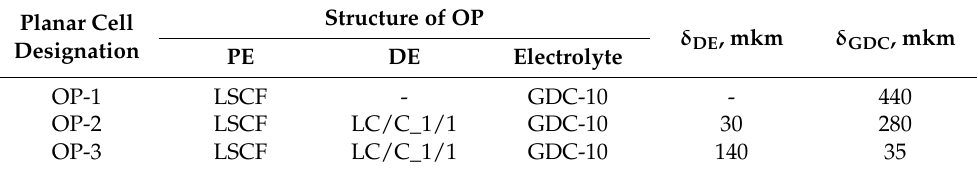
Table 3. Structure of symmetrical samples studied in the oxygen pump mode. Planar